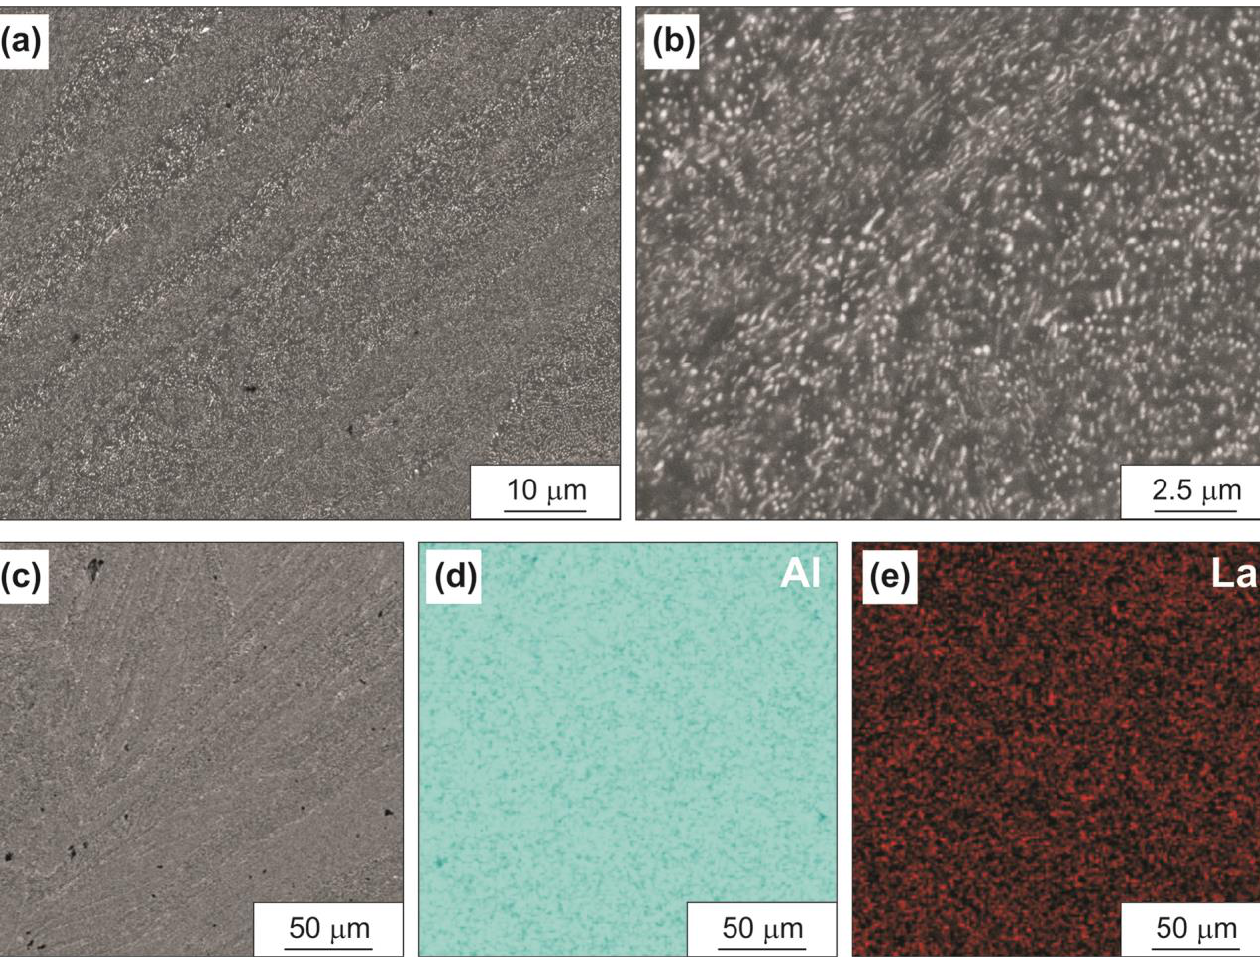
Figure 3. ( a , b ) SEM-cross sectional structure of the aluminum rod of the 5-mm diameter composite sample ( e = 2.77) and EDS results ( c – e ): ( c ) — the analyzed area of the structure and chemical distribution maps for ( d ) Al and ( e ) La.